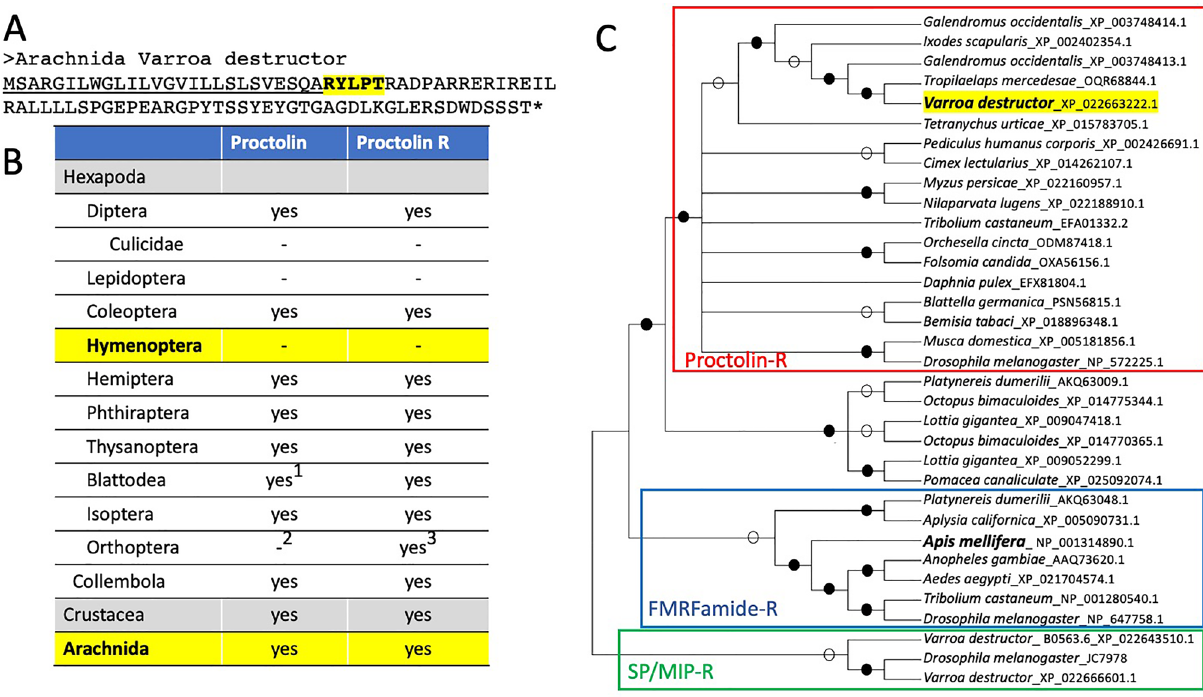
Figure 1. Taxonomic distribution of proctolin signaling system. The sequence of the proctolin of Varroa desructor ( A ), distribution of proctolin orthologous genes in arthropods ( B ) and phylogeny of the proctolin receptors rooted by FMRFamide receptors and sex peptide/myoinhibitory peptide receptors ( C ). The footnotes 1, 2, and 3, for Blattodea and Orthoptera proctolin is described in Supplementary data 1. Highlighted raw in B is for the taxonomic groups that is relevant to this study. Solid and empty circles in C are for bootstrapping values > 85% and > 50%,